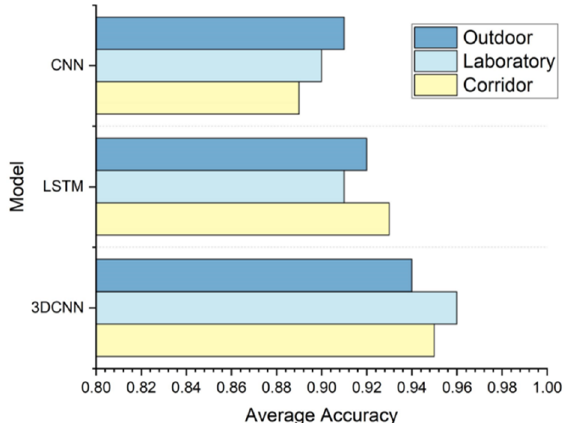
Figure 18. Comparison of different model.